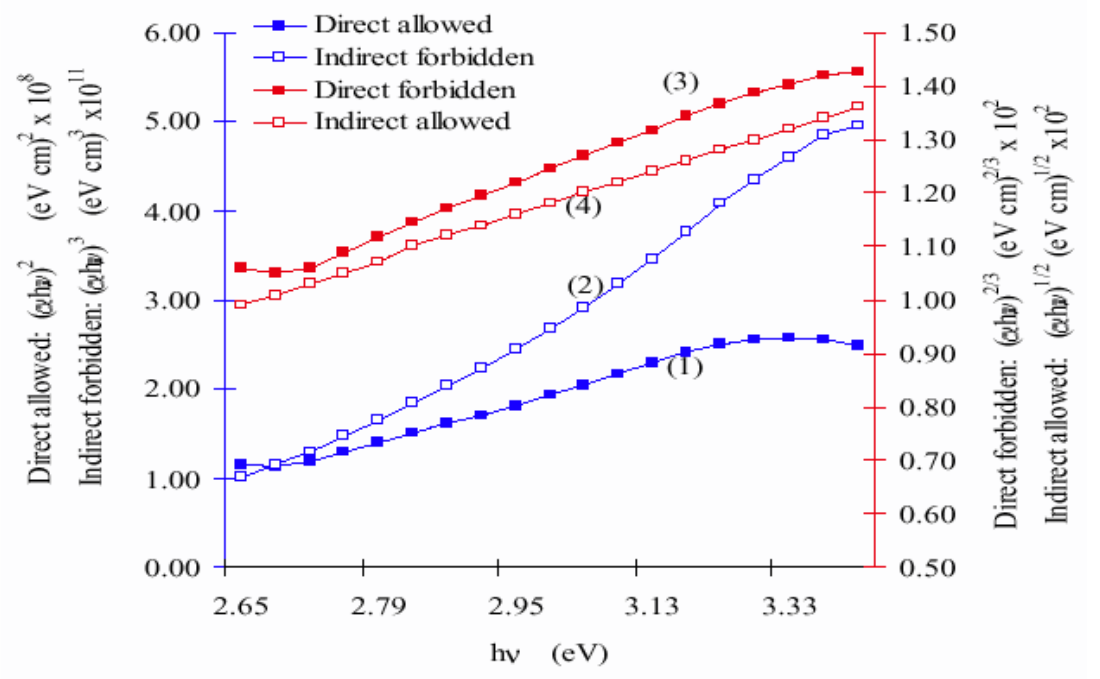
Figure 4. The effects of γ -rays on the electronic transition of MnPc thick films: The best straight line is revealed by curve (4) indicating a indirect allowed